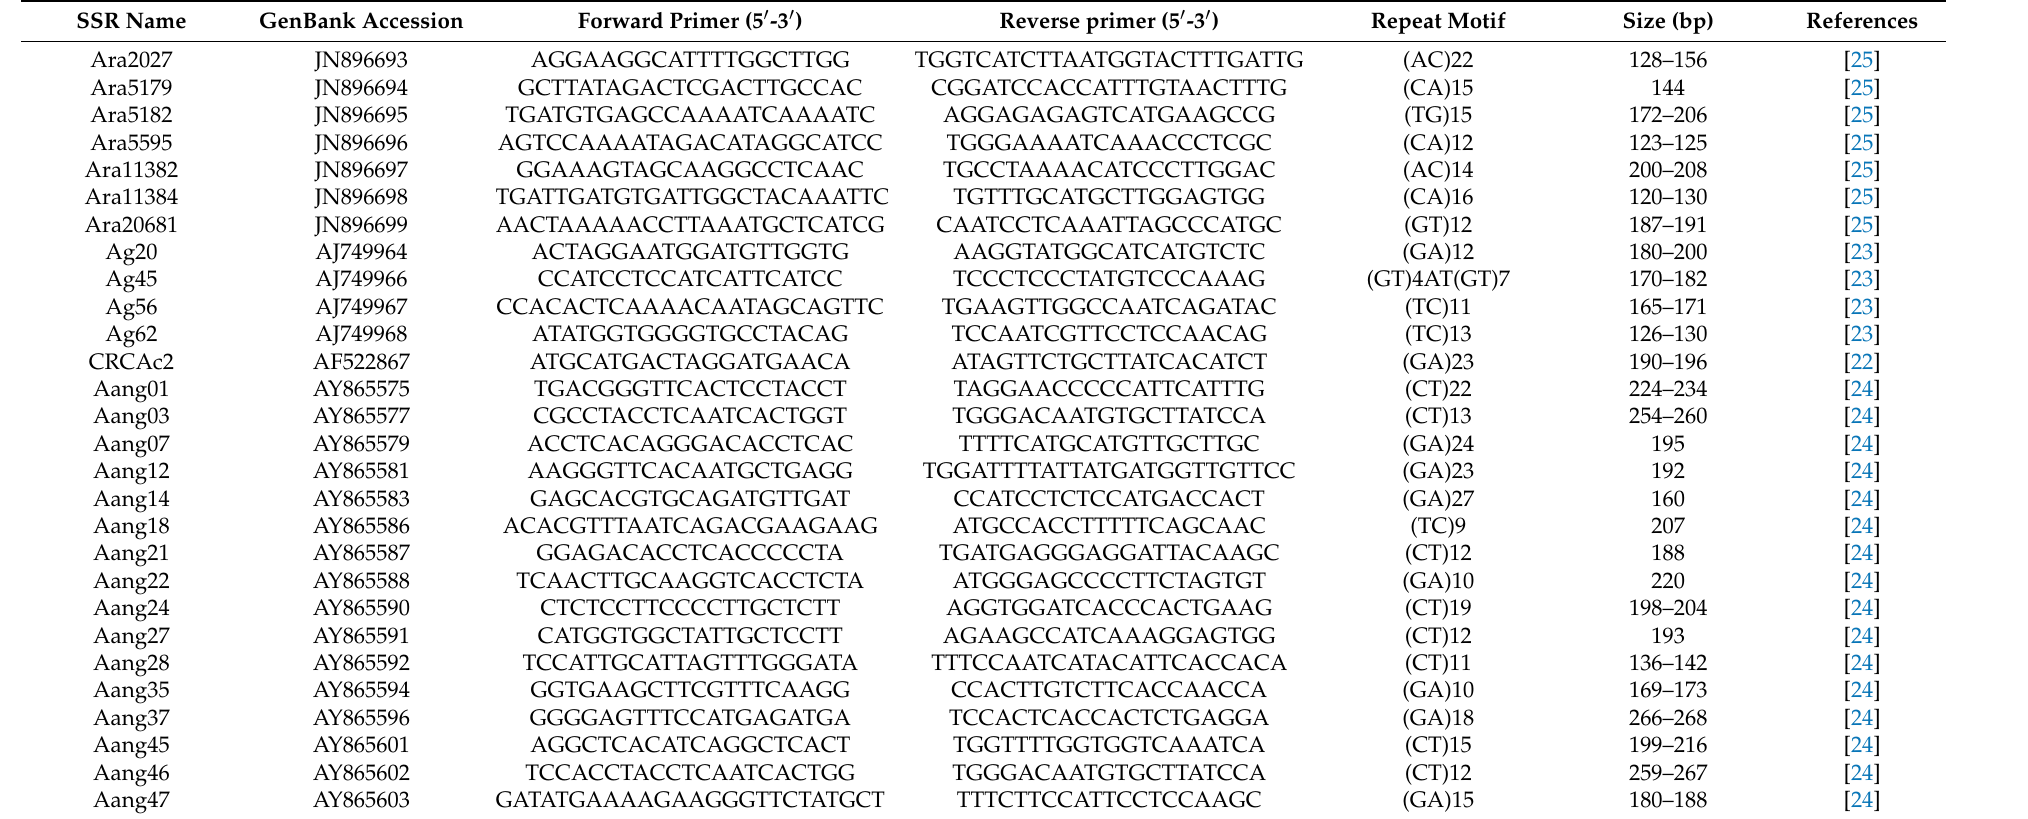
Table 2. List of the 28 SSR loci used for the A. araucana genetic analysis: SSR name, GenBank accession, forward and reverse primer sequences, repeat motifs, observed size, and